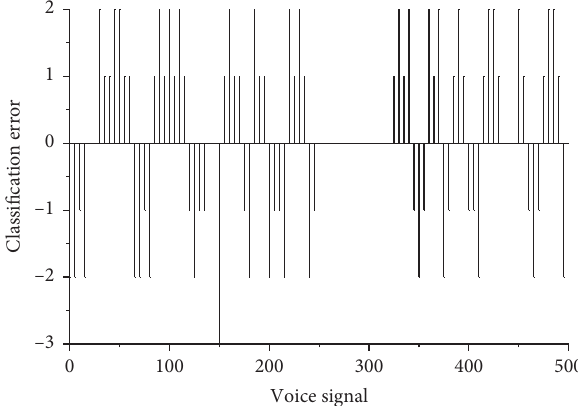
Figure 4: Classification error of BP neural network.